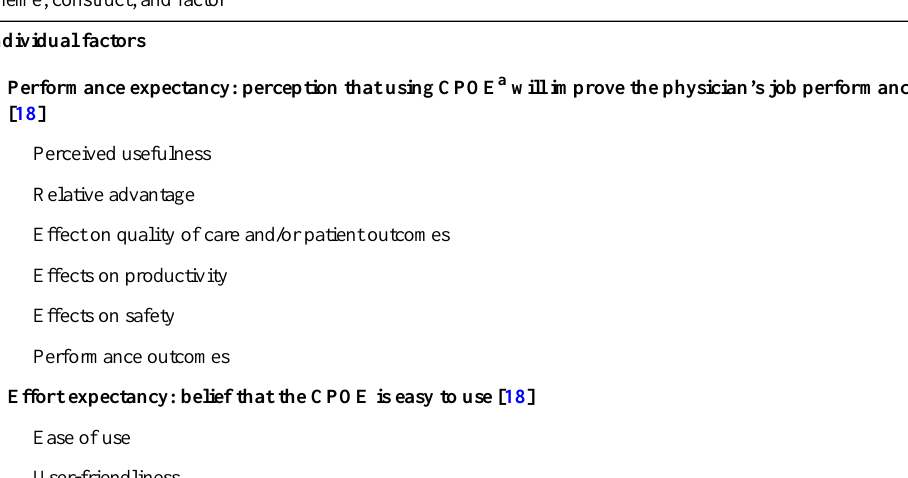
StudyStudies, nTheme, construct, and factor